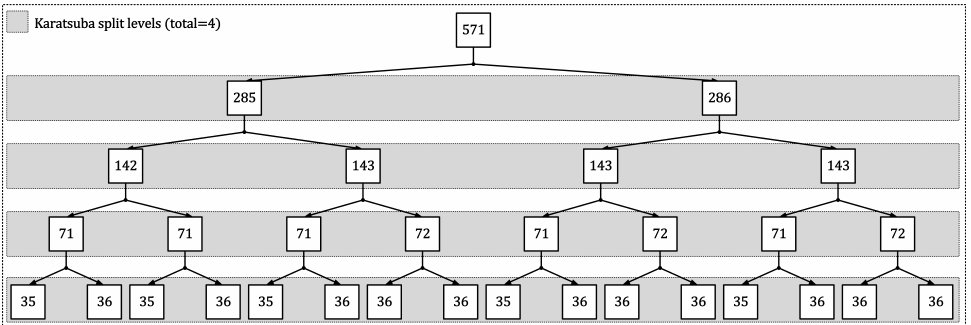
Figure 2. Polynomial splits of a Karatsuba modular multiplier over GF ( 2 571 )